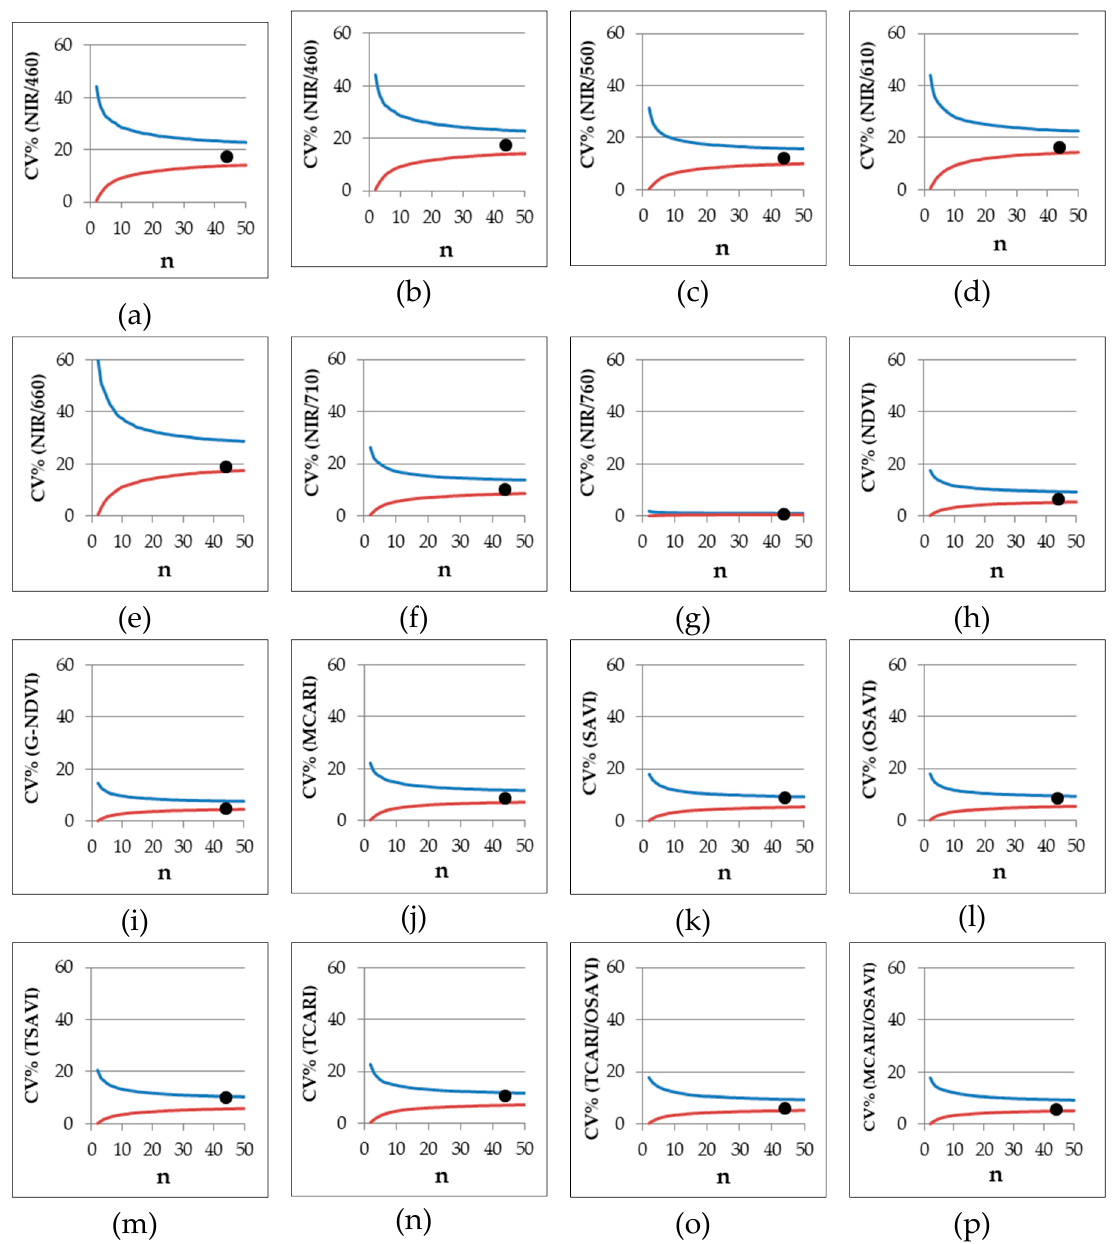
Figure 6. Experiment 5#. Coefficient of variation (CV%) limits (P = 95%) of different VIs with number of observations ranging 2–50 observations per measurement, generated with bootstrap analysis by using SET WHOLE data (see Section 2.3 data analysis) (red line, lower limit at P = 2.5%; blue line, upper limit at P = 97.5%). The filled circles represent the CV% of a set of 44 data taken for the variety Davis UC82 as assessed at 68 DAS.